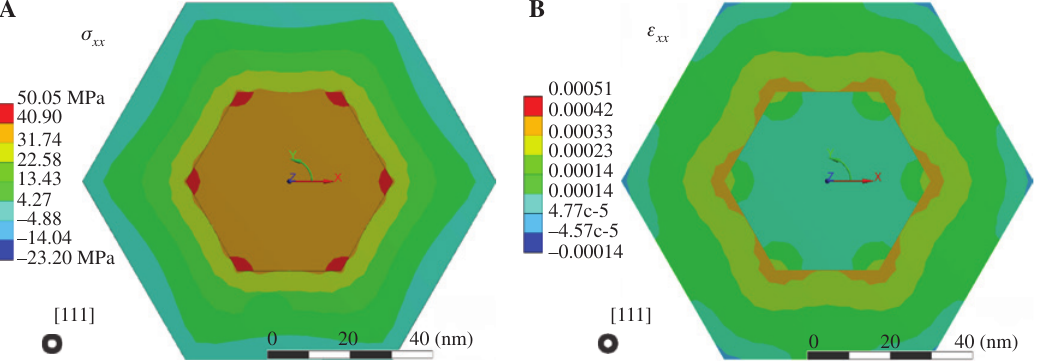
elastic stress and (B) ε elastic strain distribution in across-section of a < 111 > -oriented GaAs/ Figure 4: FE simulations of the in-plane (A) σ xx xx AlGaAs core-shell NW for 35% Al shell content and S/NW = 0.5. Stress concentrators occur at the inner core vertices, while the maximum tensile strain is observed at the outer core hexagon vertices, and relaxes towards the shell